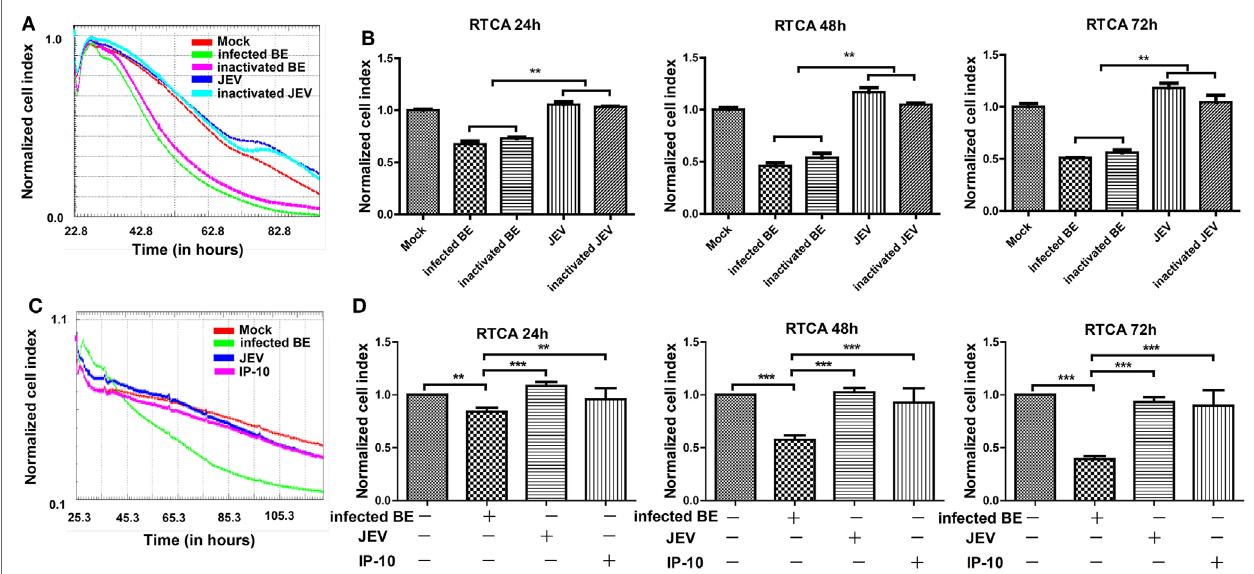
FigUre 4 | Effects of BE from Japanese encephalitis virus (JEV)-infected mice on bEnd.3 endothelial cells. Monolayers of bEnd.3 cells were treated with infected BE (BE from infected mice), inactivated BE (UV-inactivated BE from infected mice), JEV (5 MOI), inactivated JEV (UV-inactivated JEV), IP-10 (200 ng/ml), or mock treatment (BE from mock-treated mice). (a,B) Representative graph of normalized bEnd.3 CIs with different treatments, which were quantified at 24, 48, and 72 h. (c,D) Representative graph of normalized bEnd.3 CIs with IP-10 treatment, which were quantified at 24, 48, and 72 h. The results reflect the means of three individual wells ± SEMs. ** p < 0.01; *** p <